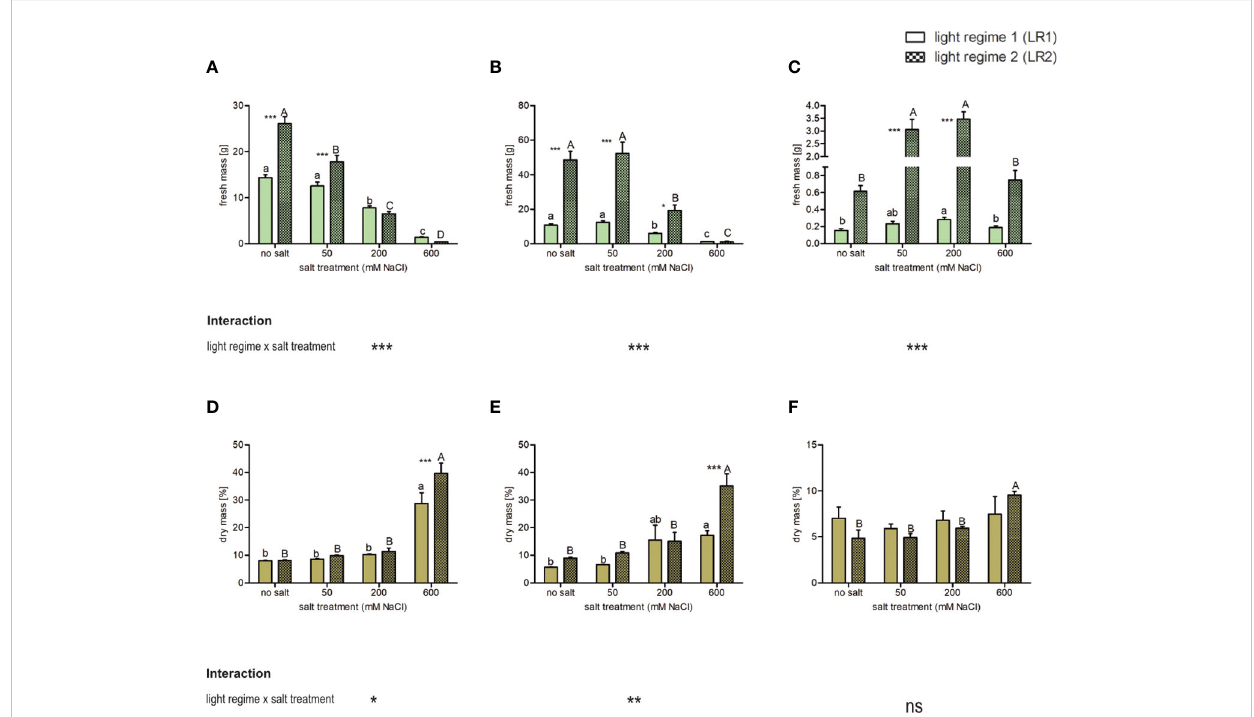
FIGURE 1 In fl uence of salt treatment and light regime on the fresh mass of plants and percent dry mass (as a percentage of fresh mass) of the leaves of 6- to 9-week-old plants. Fresh mass (A – C) and dry mass (D – F) of (A, D) Cochlearia of fi cinalis , (B, E) Atriplex hortensis , and (C, F) Salicornia europaea . Fresh mass: the bar represents means ± SEM, n = 24; dry mass: the bar represents means ± SEM of n = 8 pools of three individual plants each from two independent experiments. Small letters indicate signi fi cant differences between salt treatments in light regime 1 (LR1, greenhouse)